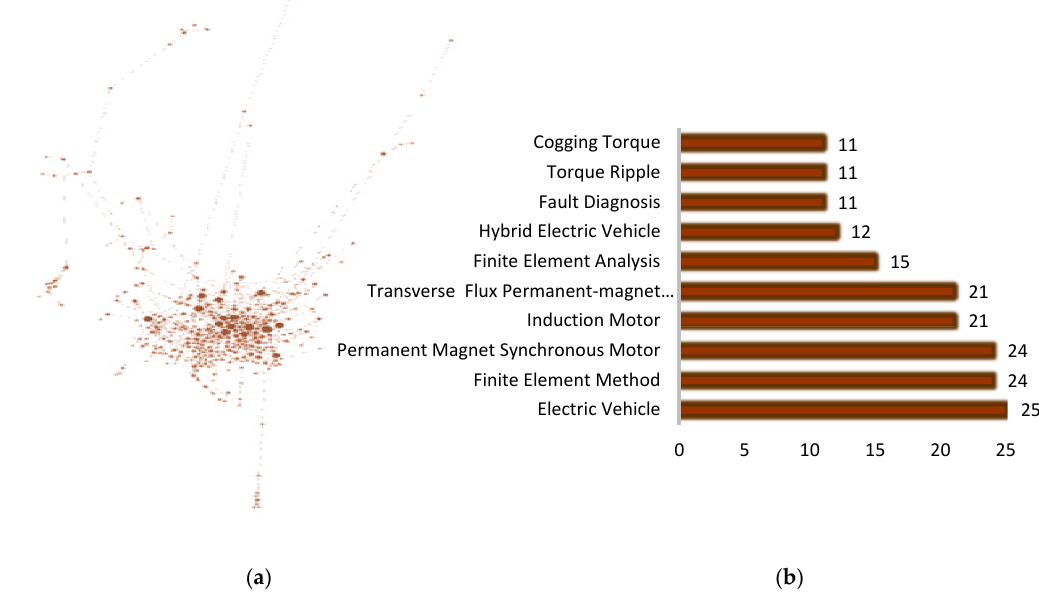
Figure 22. Electric motor advancements: ( a ) manuscripts published, ( b ) keywords.